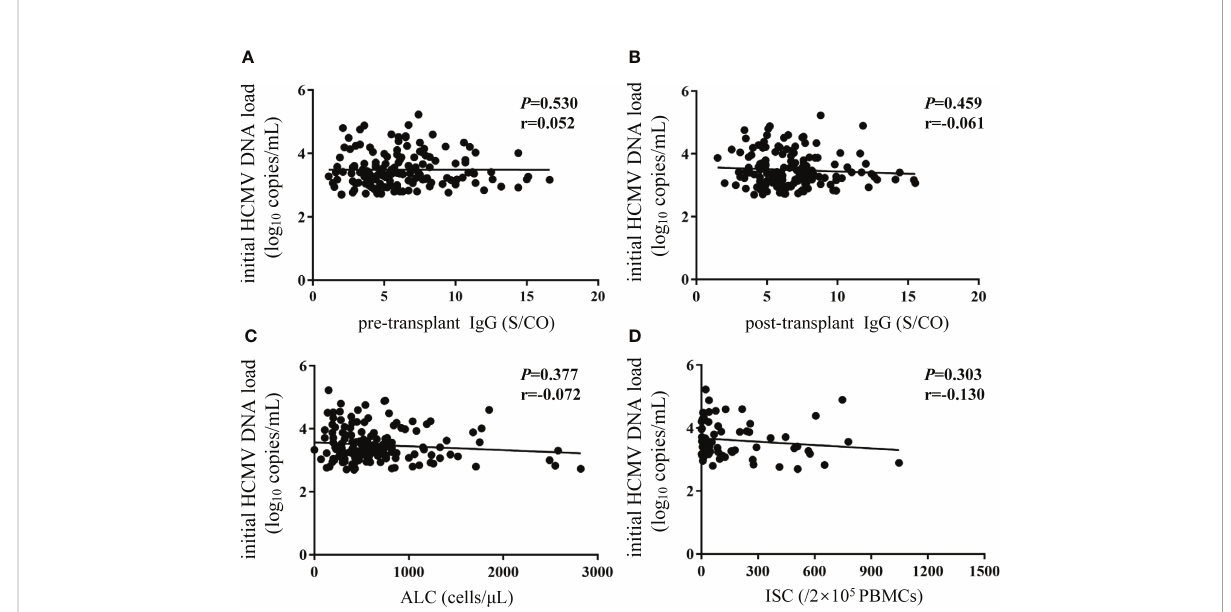
FIGURE 6 No correlations were observed between initial HCMV DNA load and biomarkers. Y-axis corresponds to log10 scale. The initial HCMV DNA load was de fi ned as the fi rst detectable DNA load after transplantation. (A, B) pre- and post-transplant HCMV IgG antibody concentrations; (C) ALC; (D) ISCs. The P value indicates level of signi fi cance and r, the correlation coef fi cient. HCMV, human cytomegalovirus; ALC, absolute lymphocyte count; ISCs, HCMV speci fi c IFN- g secreting